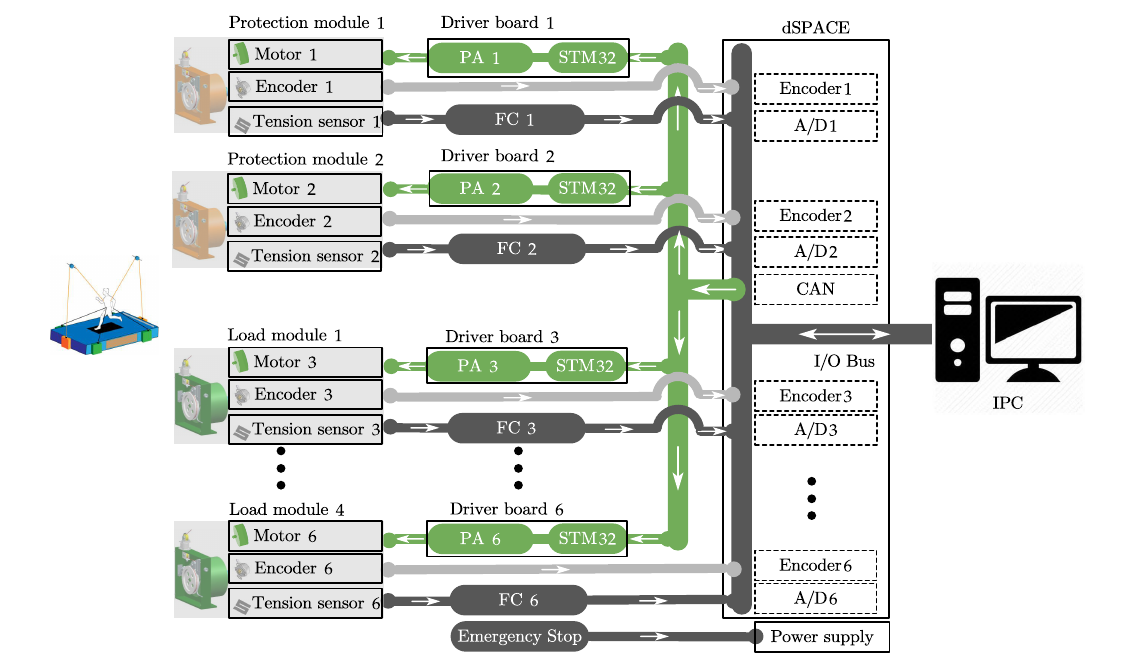
Figure 13. Overall control plan of CAPE.